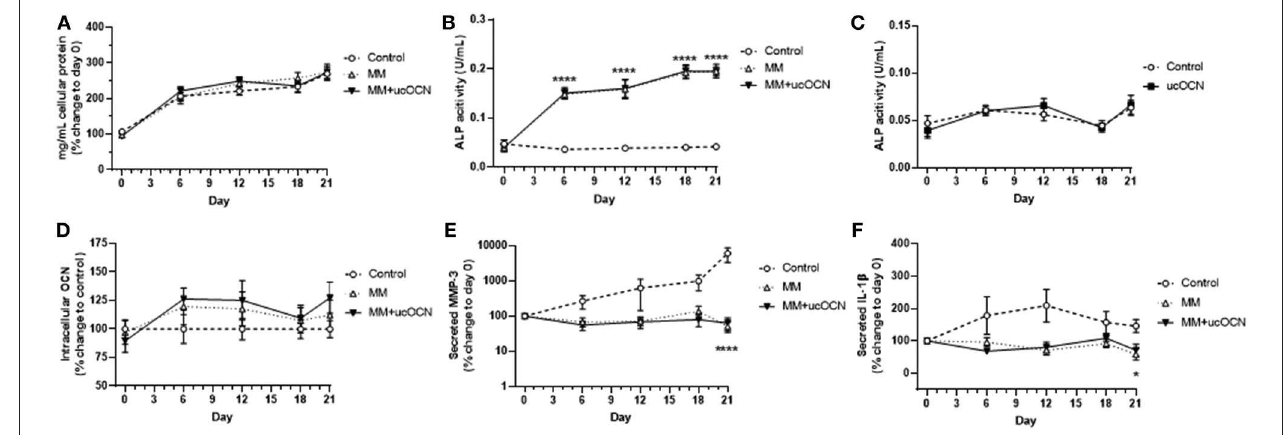
FIGURE 3 | Human aortic smooth muscle cells were grown in usual growth media (control), or mineralisation inducing media (MM) with or without ucOCN (10ng/mL). Total protein content (A) , ALP activity (B) , intracellular total osteocalcin (D) , secreted MMP-3 (E) , and secreted IL-1 β (F) were measured at days 0, 6, 12, 18, and 21. ALP activity was also measured in control and control + ucOCN treated cells (C) . Data are represented by means with error bars representing SEM. Data were analyzed by two-way ANOVA using mixed effects analysis and Dunnett’s test for multiple comparisons with * p < 0.05 and **** p < 0.0001 compared to control.